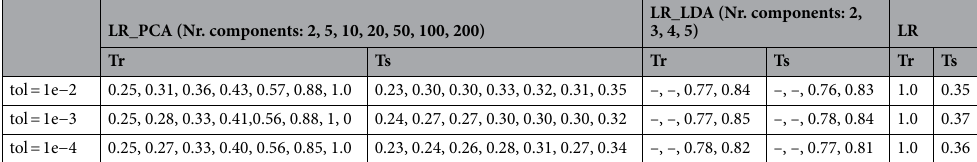
Table 2. Result of snake image classification using logistic regression algorithm.